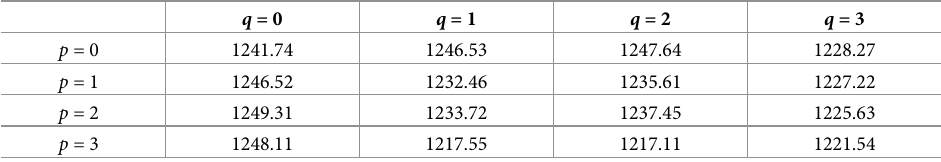
Table 4. BIC test for monthly cases number of hepatitis E by p , q .